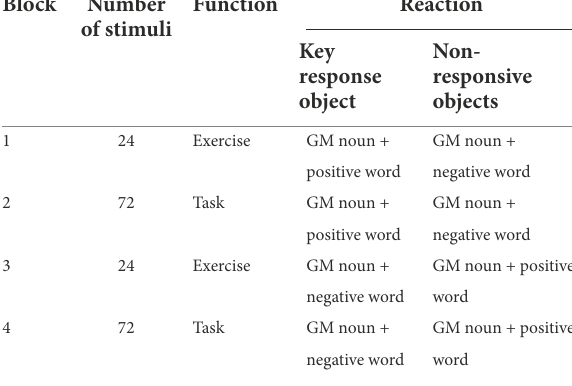
TABLE 5 GNAT experimental procedures.